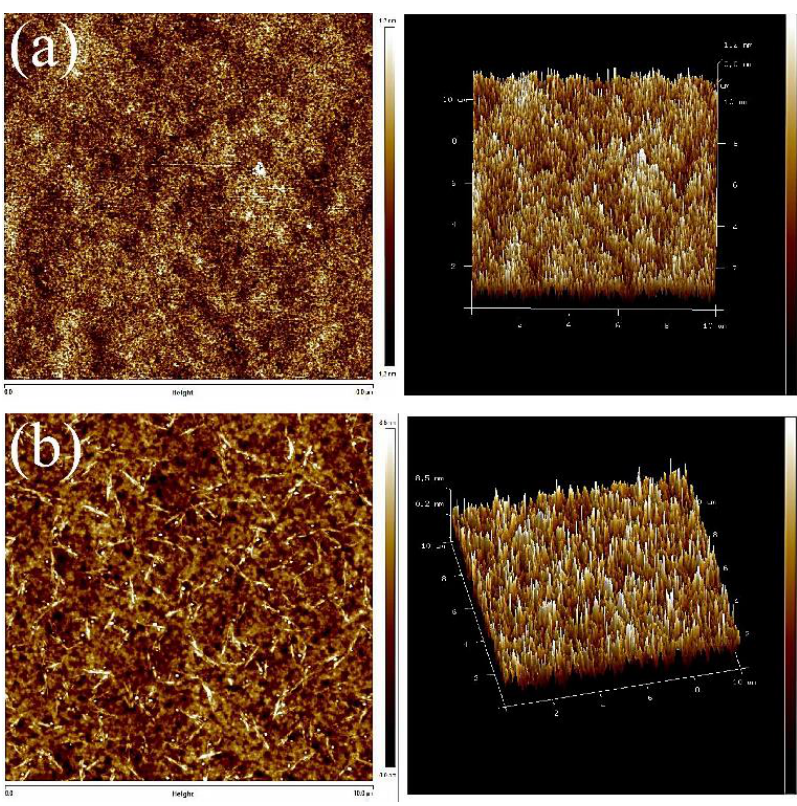
Figure 6. AFM scanned images: ( a ) PCDL-1,3-BDO, ( b ) PCDL-1,4-BDO.